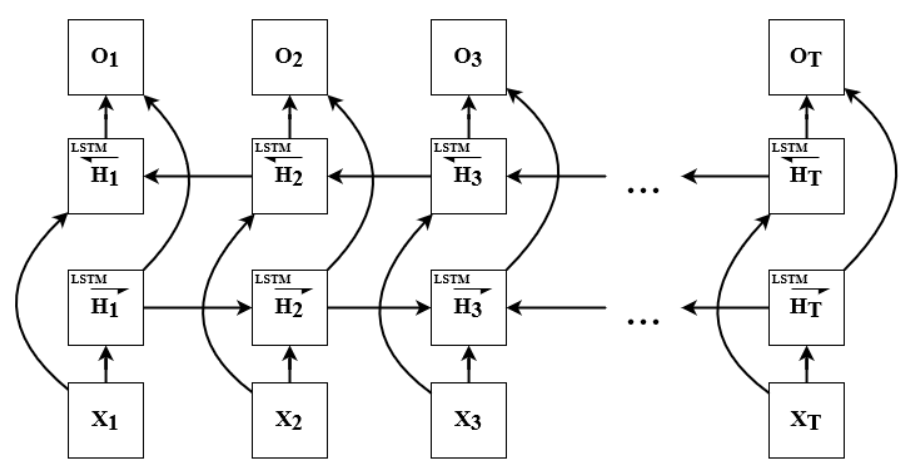
Figure 2. Architecture of Bidirectional LSTM (BiLSTM).